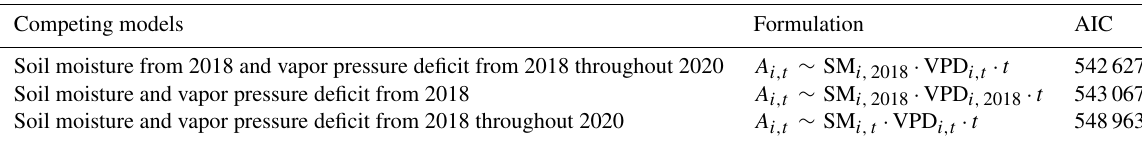
Figure 1. (a) Forest disturbance anomalies in the years 2018–2020 relative to 1986–2015, estimated from satellite-based disturbance maps across Europe. Anomalies are expressed in percent area change; that is + 100% indicates a doubling of the disturbed forest area relative to the average disturbed forest area in the period 1986–2015. Anomalies were calculated at a grid of ∼ 9km. (b) Summer (JJA) soil moisture anomalies ( z scores) in relation to the period 1986–2015 at the same spatial grain as (a) . (c) JJA vapor pressure deficit ( z scores) in relation to the period 1986–2015 at the same spatial grain as (a) . Background maps are from https://gadm.org (last access: 21 September 2021). Table 1. Competing models compared for linking soil moisture (SM) and vapor pressure deficit (VPD) anomalies with disturbance anomalies ( A ) across Europe. The models use soil moisture and vapor pressure deficit from different years ( t ). Models are compared using Akaike’s information criterion (AIC), with smaller values indicating higher support of the model from the